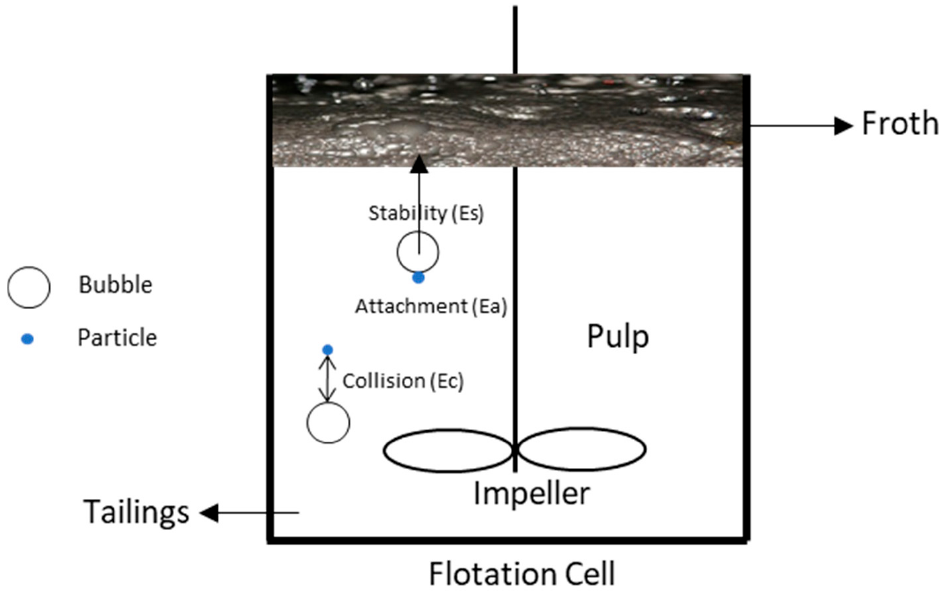
Figure 1. Sub-processes of particle–bubble interactions along with their predominant regions, modi- fied from [6].